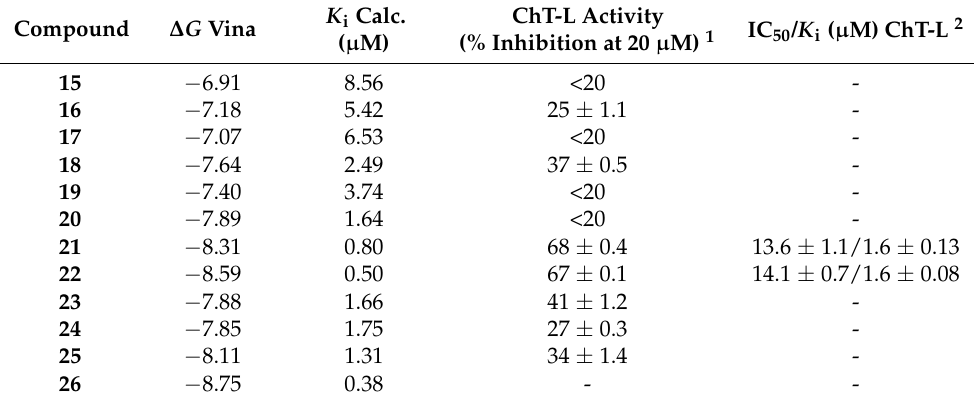
Figure 3. BOILED-Egg plot. Points located in the BOILED- Egg’s yolk (yello w) represent the mole- cules predicted to passively permeate through the blood-brain barrier, whereas the ones in the egg white are relative to the molecules predicted to be passively absorbed by the gastrointestinal tract; the blue dots ( 21 ) indicate the molecules for which it was expected to be effluated from the CNS by the P-glycoprotein, whereas the red ones ( 22 ) point to the molecules predicted not to be effluated from the CNS by the P-glycoprotein.